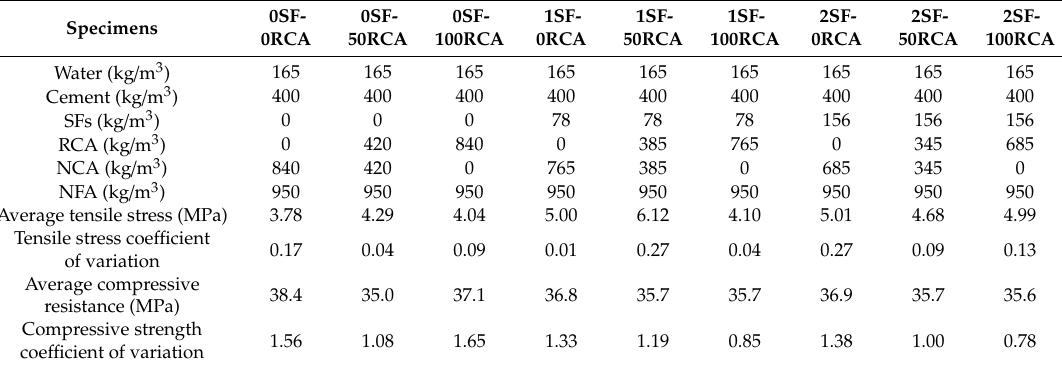
Table 2. Concrete mixes’ compositions and strengths.